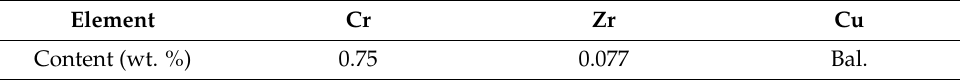
Table 1. Chemical compositions of CuCrZr alloy powders.